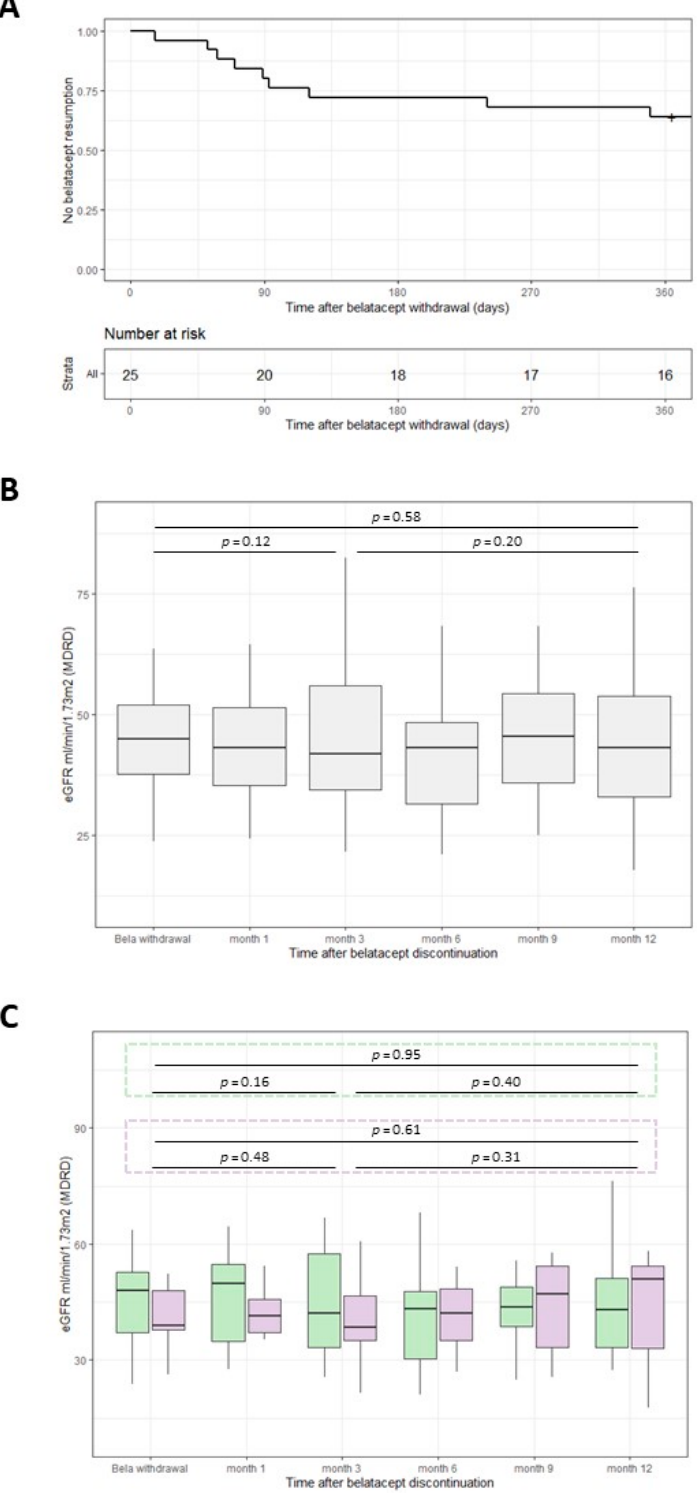
Figure 3. Effect of belatacept discontinuation/CNIs resumption on eGFR ( n = 25). ( A ) Kaplan–Meier analysis of time to belatacept resumption during the first year post-belatacept-discontinuation; ( B ) evolution of the eGFR during the first year after belatacept discontinuation ( n = 25); ( C ) evolution of the eGFR during the first year after belatacept discontinuation according to their belatacept-status: green boxplots correspond to patients without belatacept ( n = 15) and the purple ones to patients having resumed belatacept as shown in A ( n = 10).